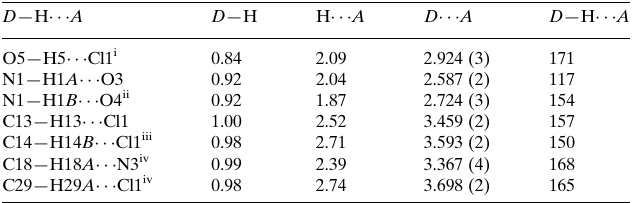
Hydrogen-bond geometry (A˚ , (cid:4)